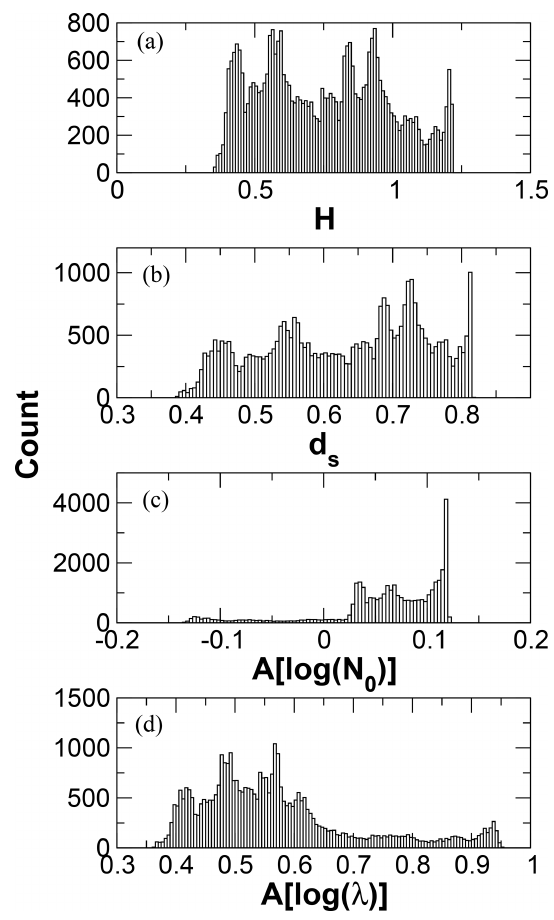
Figure 13. Distributions of information content metrics for the ACR retrieval.